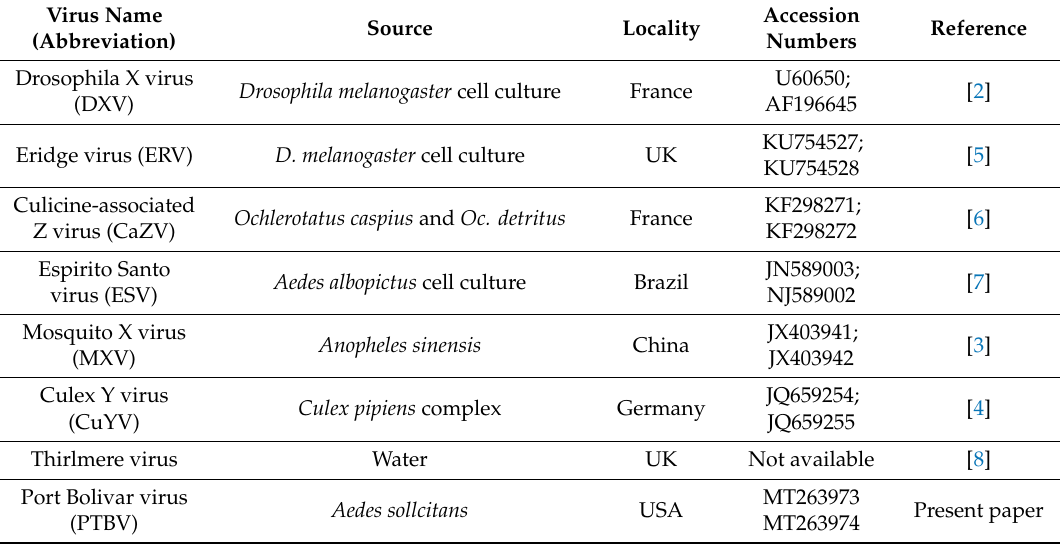
Names, original source, locality, and accession numbers of currently recognized entomobirnaviruses